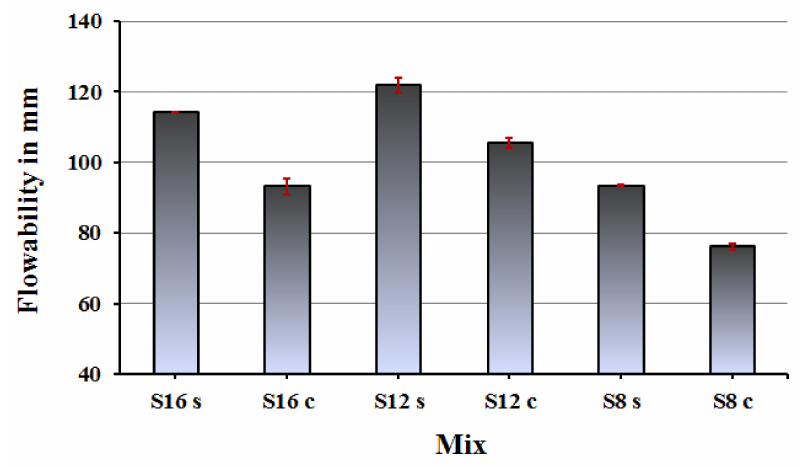
Figure 7. Flowability results of the AAS mortars as an average of the spread diameters.